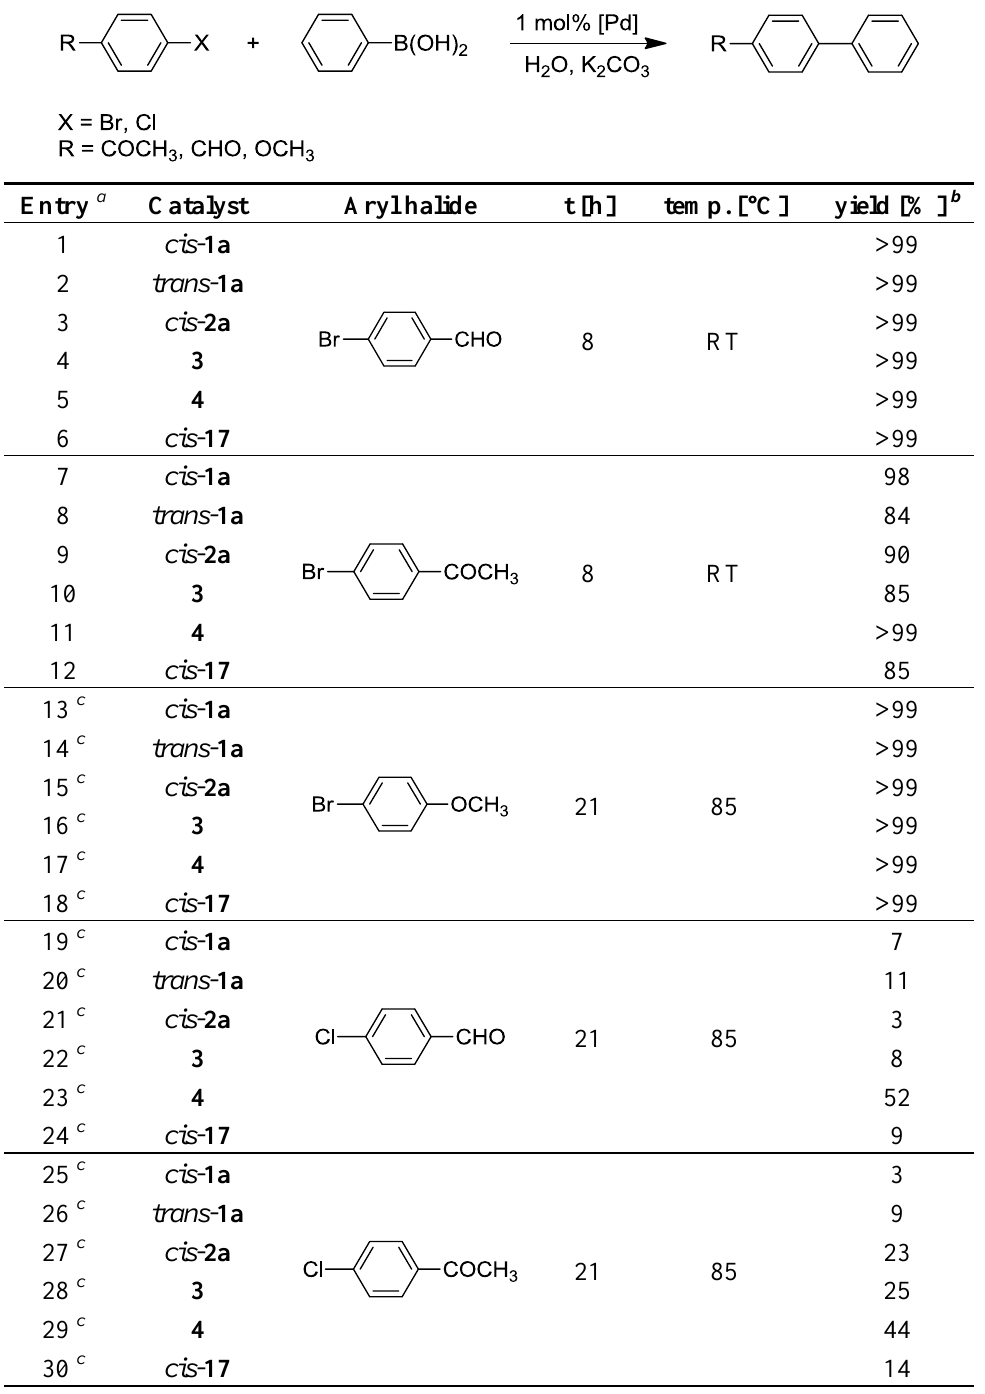
Table 2. Suzuki-Miyaura coupling reactions a catalyzed by 1a , cis - 2a , 3 , 4 and cis - 17